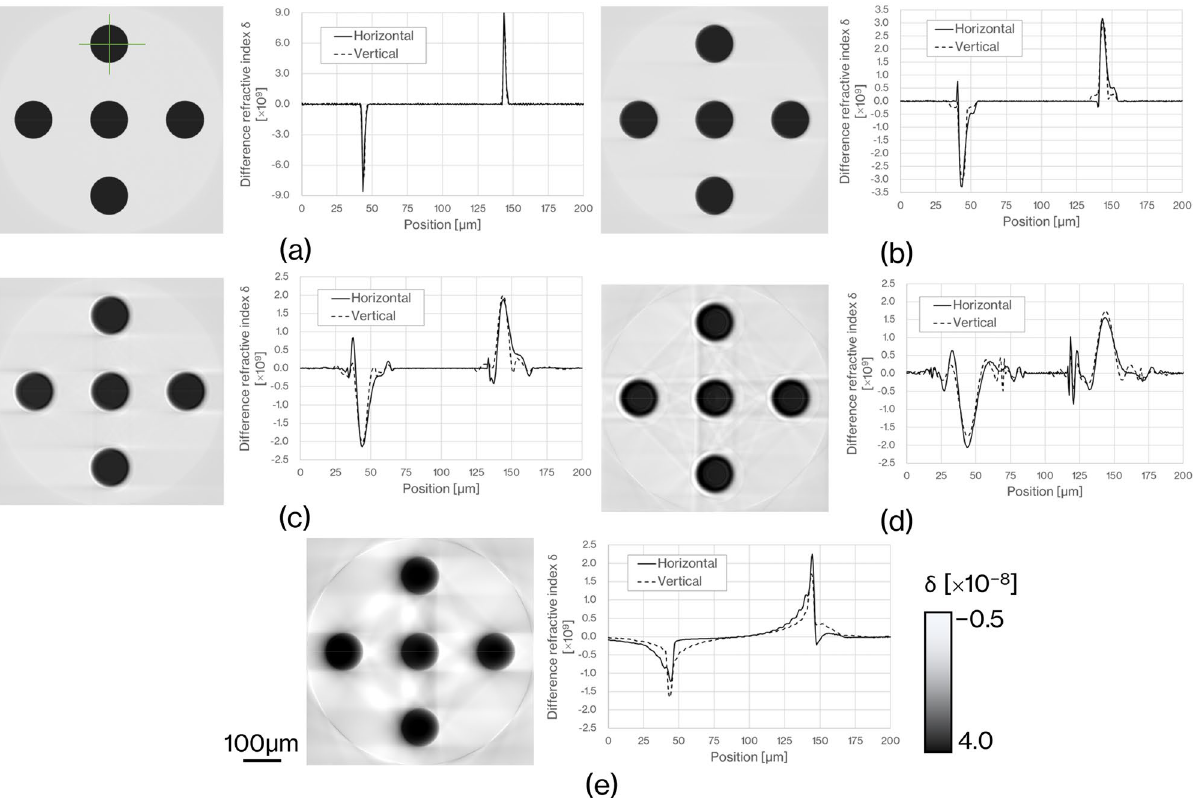
Figure 4. Reconstructed images and LSFs in the horizontal and vertical directions of the numerical phantom comprising circles having a diameter of 100 µm. LSFs were constructed by differentiating the line profile (green line) of the image by each thickness condition. ( a ) LAA thickness of 24 µm, ( b ) LAA thickness of 71 µm, ( c ) LAA thickness of 166 µm, ( d ) LAA thickness of 356 µm, and ( e ) BAA thickness of 500 µm.